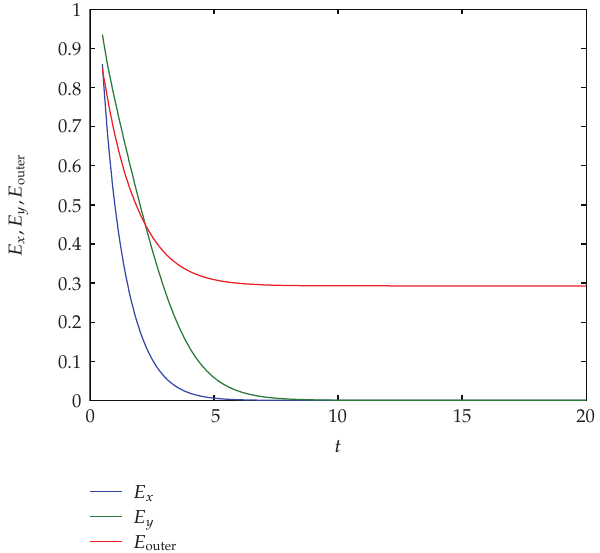
Figure 6: Inner and outer synchronization evolution curves with r x (cid:7) 0 . 5, r y (cid:7) 0 . 2, τ x (cid:7) 0 . 3, τ y (cid:7) 0 . 5, ρ 1 (cid:7) − 0 . 3, ρ 2 (cid:7) 0 . 6, and N (cid:7)